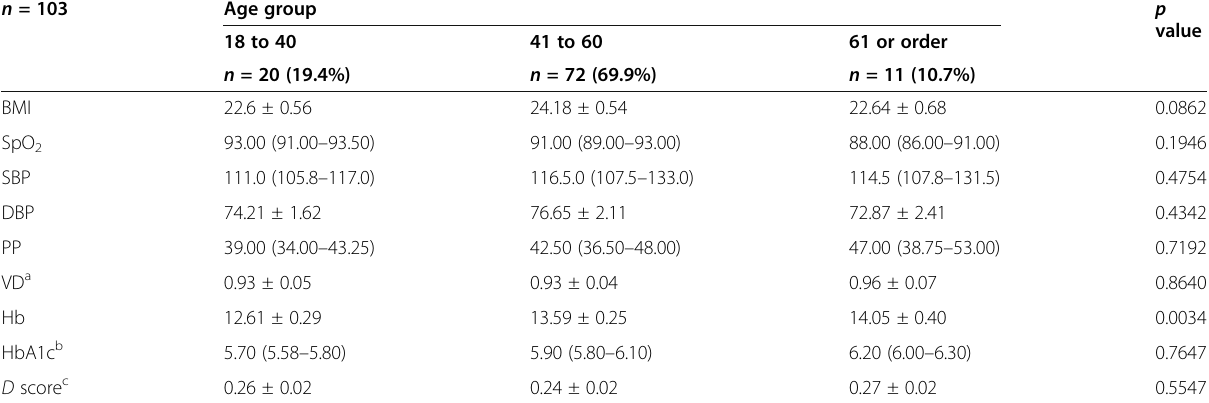
Table 3 Anthropometric variables, biochemical data, and poverty index by the age group in females. Values are presented as the mean ± SE or median (1st quartile – 3rd quartile). Data were analyzed by ANOVA or the Kruskal-Wallis test to compare variables among the three age groups. The D score was considered poor at ≥